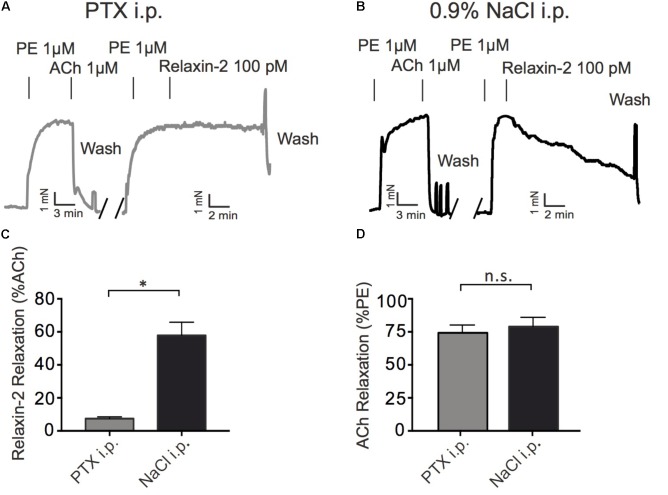
Effects of treatment of mice with pertussis toxin (PTX) or sham (0.9% NaCl) on relaxin-2 relaxations. (A) Original representative recording of relaxin-2 induced relaxations in arteries of PTX treated mice. (B) Original representative recording of relaxin-2 induced relaxations in arteries of 0.9% NaCl treated (control) mice. (C) Summary data of relaxin-2 induced relaxation. (D) Summary data of ACh induced relaxation. PTX group; n = 11 out of eight mice. 0.9% NaCl group; n = 7 out of four mice. ∗P < 0.05 using unpaired t-test; n.s., not significant.